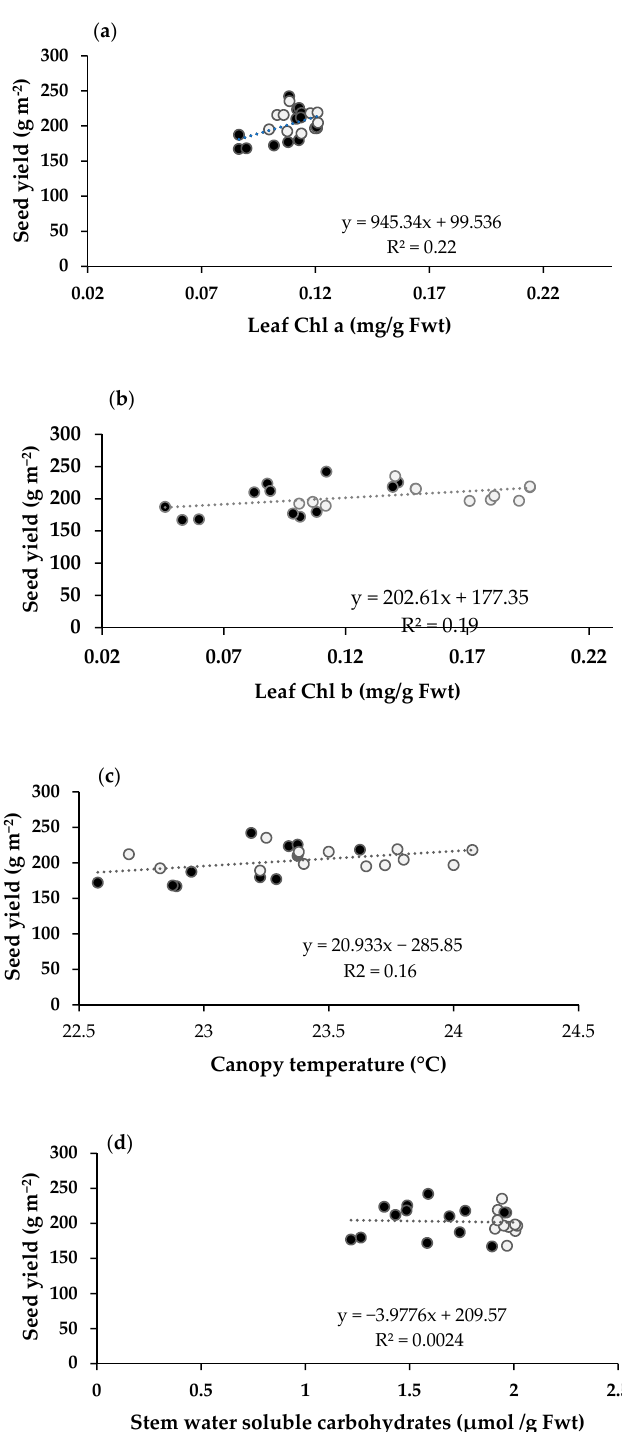
Figure 2. Regression relationship of seed yield with ( a ) leaf Chl a, ( b ) Chl b, ( c ) canopy temper-ature ( d ) stem water soluble carbohydrates. Filled box with black color indicate the data val-ues for timely planted and white filled for late planted wheat